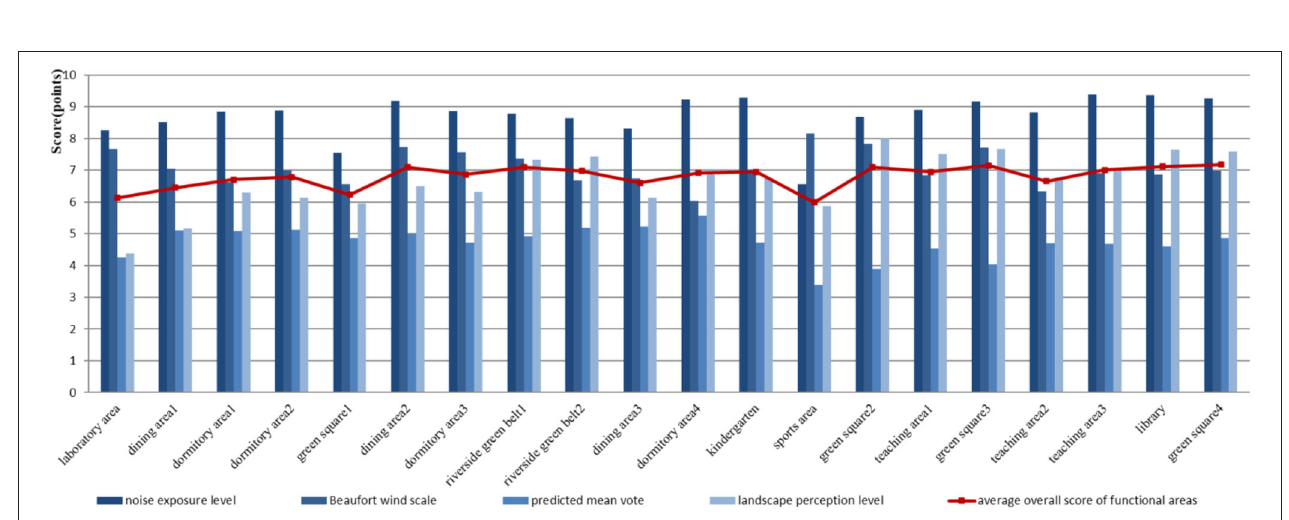
Frontiers in Public Health |